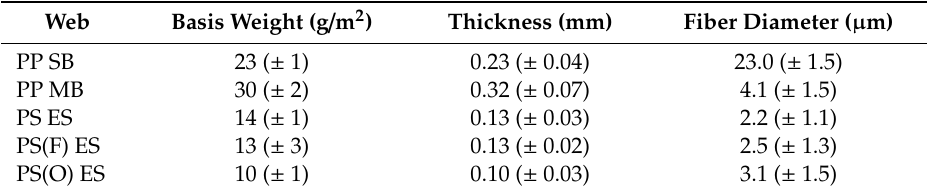
Table 2. Characteristics of